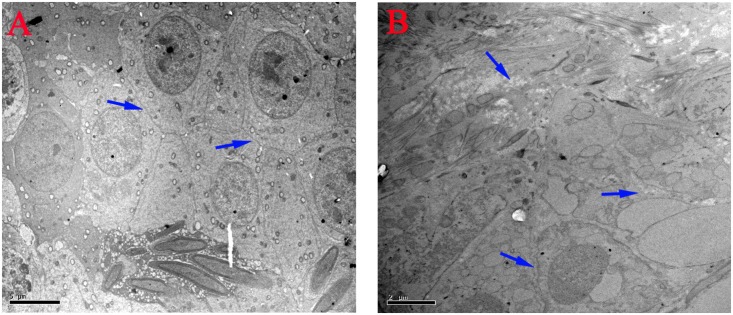
Effect of MEQ on the ultrastructure of BTB under TEM (Scale bar = 5 μm, Scale bar = 2 μm). (A) BTB from the control group. (B) BTB from the 110 mg/kg. Arrows show the destroyed integrity of the BTB.